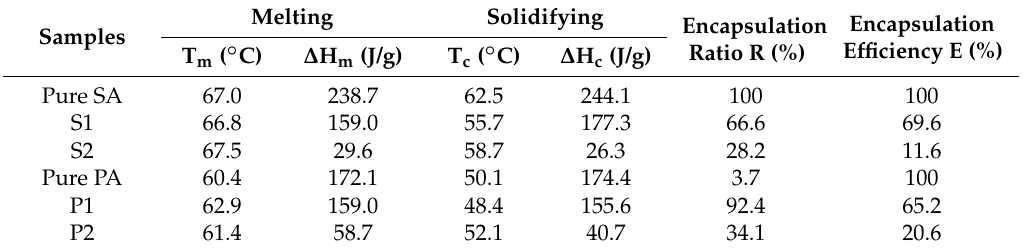
Figure 4. TEM images of the as-prepared samples: ( a , b ) the SA/AgBr micro/nanocapsules; ( c , d ) the PA/AgBr micro/nanocapsules, and ( e , f ) the beeswax/AgBr micro/nanocapsules. Table 2. DSC data for the prepared fatty acid/AgBr micro/nanocapsules. Samples